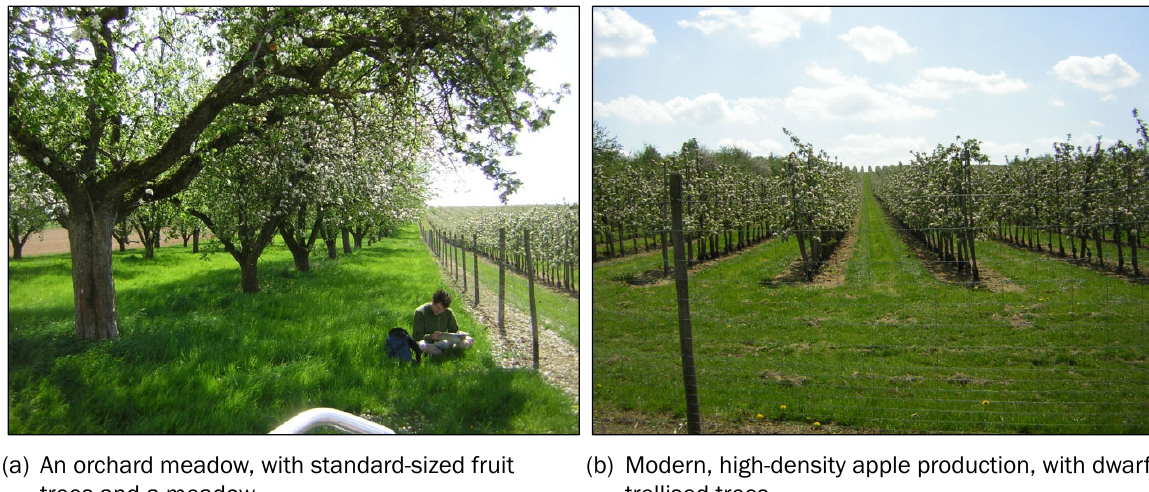
Figure 1. An Orchard Meadow and Modern, High-density Apple Production in Southwestern Germany